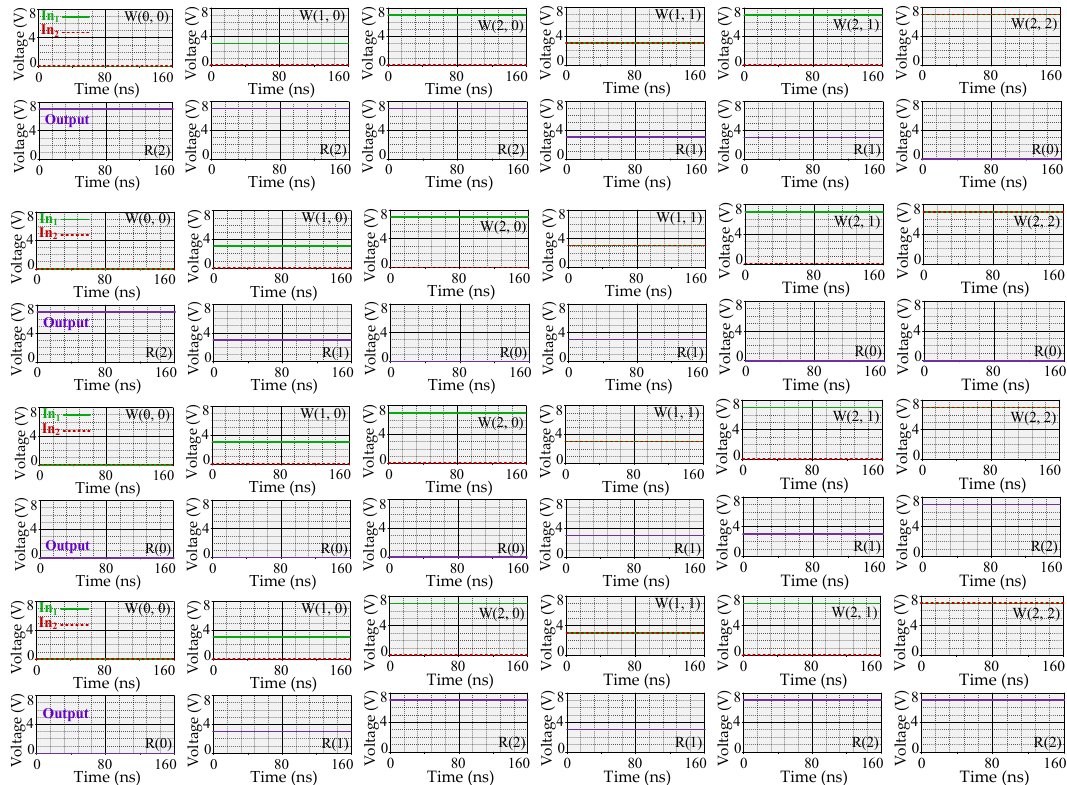
Figure 6. The simulation results of four basic ternary logic gates (including the NAND, NOR, AND, and OR gates).